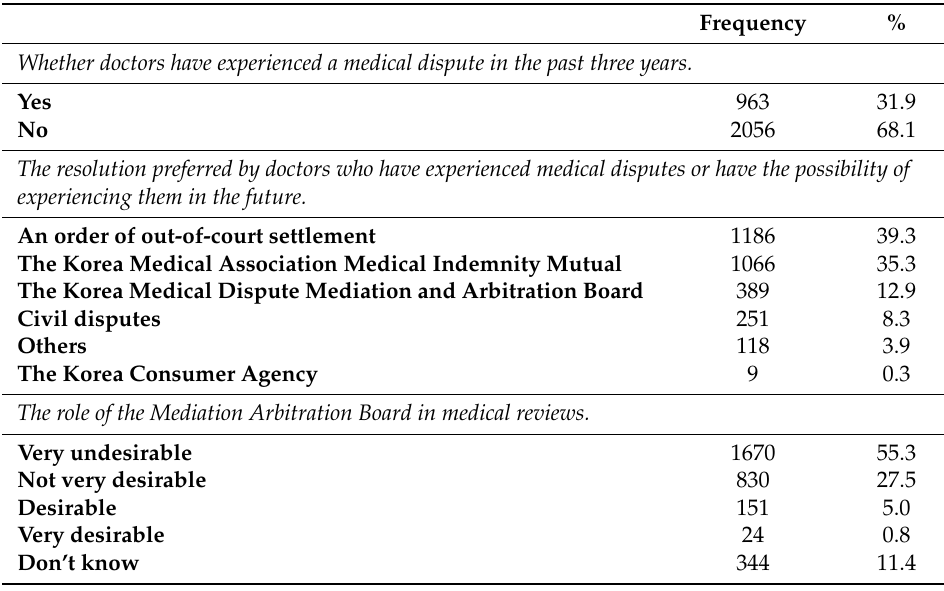
Table 4. Possible resolutions for medical